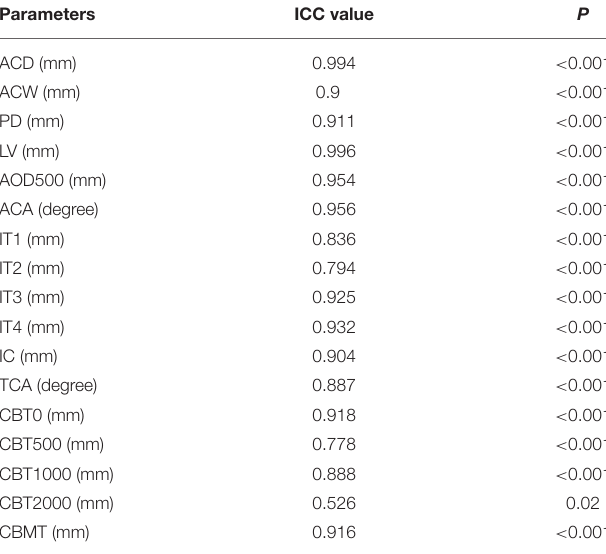
TABLE 3 | Intraclass correlation coefficient